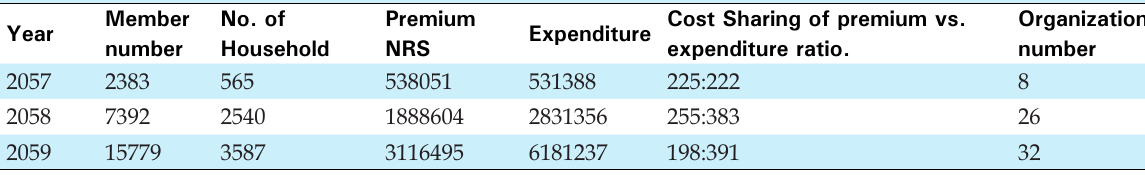
Table 2. Utilization of Services department wise 3 years.